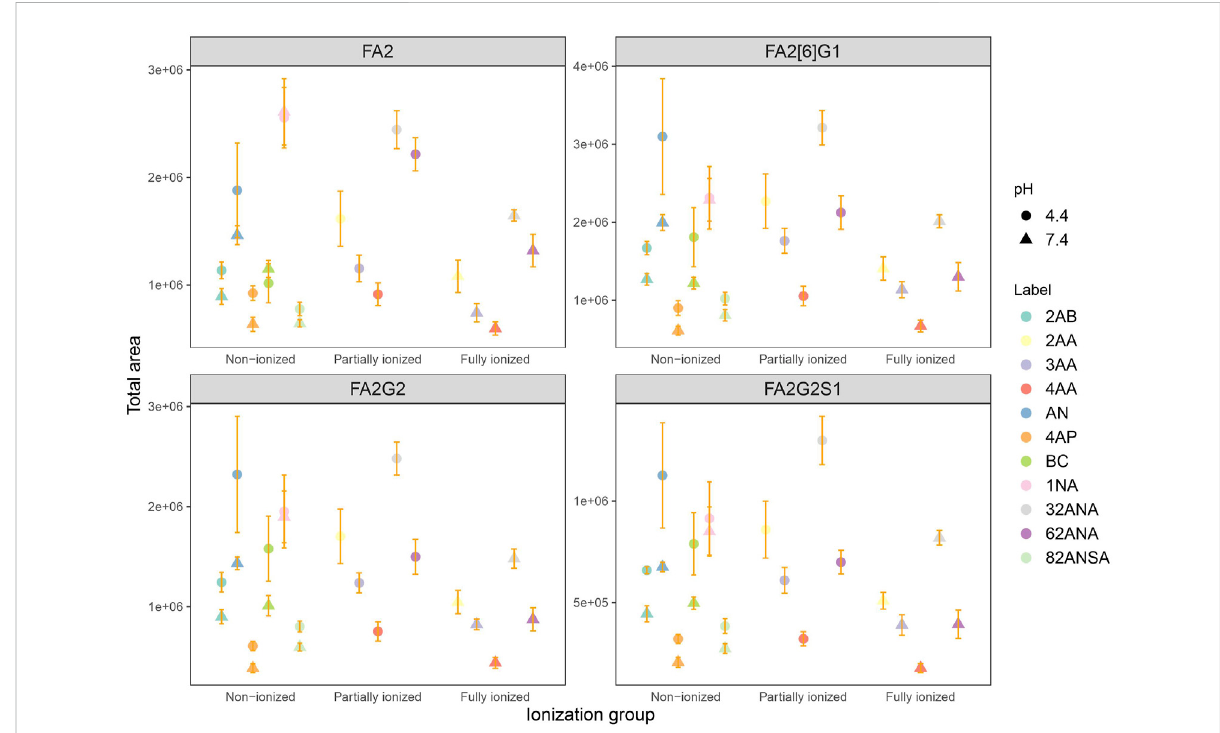
FIGURE 3 Comparison of total area of all labels grouped by their ionization for 4 most intensive peaks at pH 4.4 and 7.4 in the same laboratory. Error bars represent the standard deviation of pentaplicates